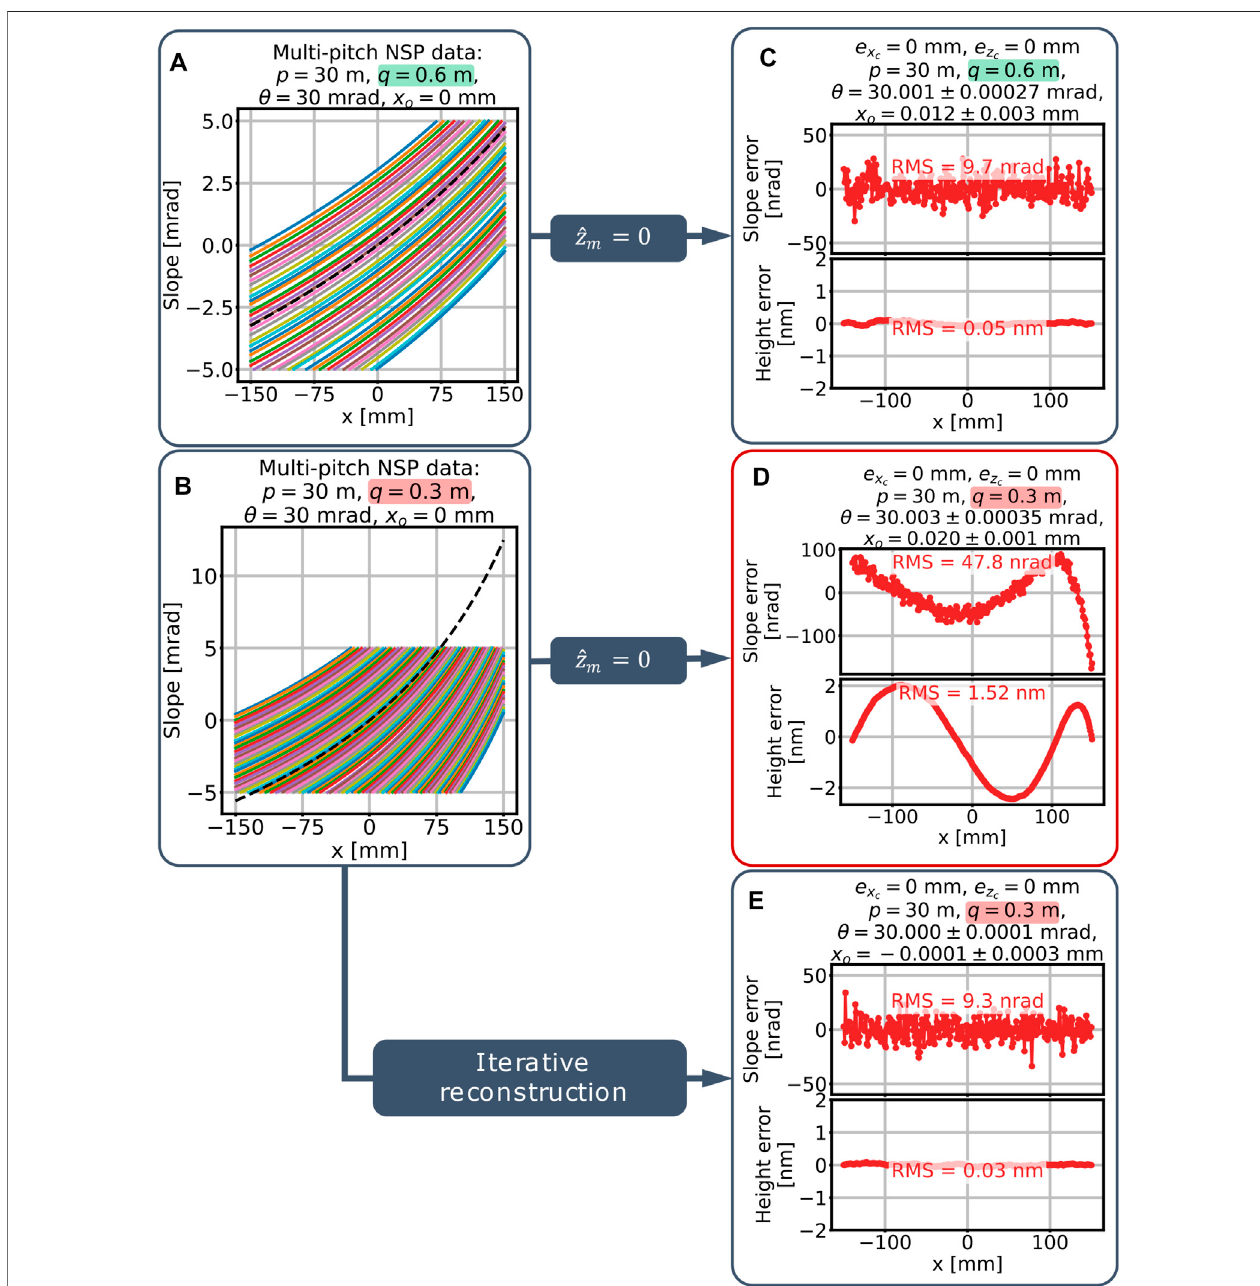
FIGURE4| The “ fl atassumption ” ( ^ z m (cid:2) 0)doesnotalwaysworkwhenreconstructingthe “ extreme ” ellipseinmulti-pitchNSP.Itisdemonstratedwiththesimulated multi-pitch NSP dataset for (A) a “ relaxed ” ellipse with p (cid:2) 30 m, q (cid:2) 0.6 m, θ (cid:2) 30 mrad (mirror sag (cid:2) 328 µm), (B) the default ellipse with p (cid:2) 30 m, q (cid:2) 0.3 m, θ (cid:2) 30 mrad (mirror sag (cid:2) 777 µm). By optimizing θ and x o , the best fi tting results of (C) the “ relaxed ellipse ” with the “ fl at assumption ” , (D) the default ellipse with fl at assumption, and (E) the default ellipse with the proposed iterative